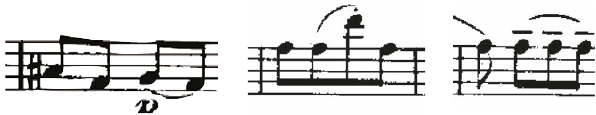
Figure 2: Di ff erent note groups, corresponding to the same